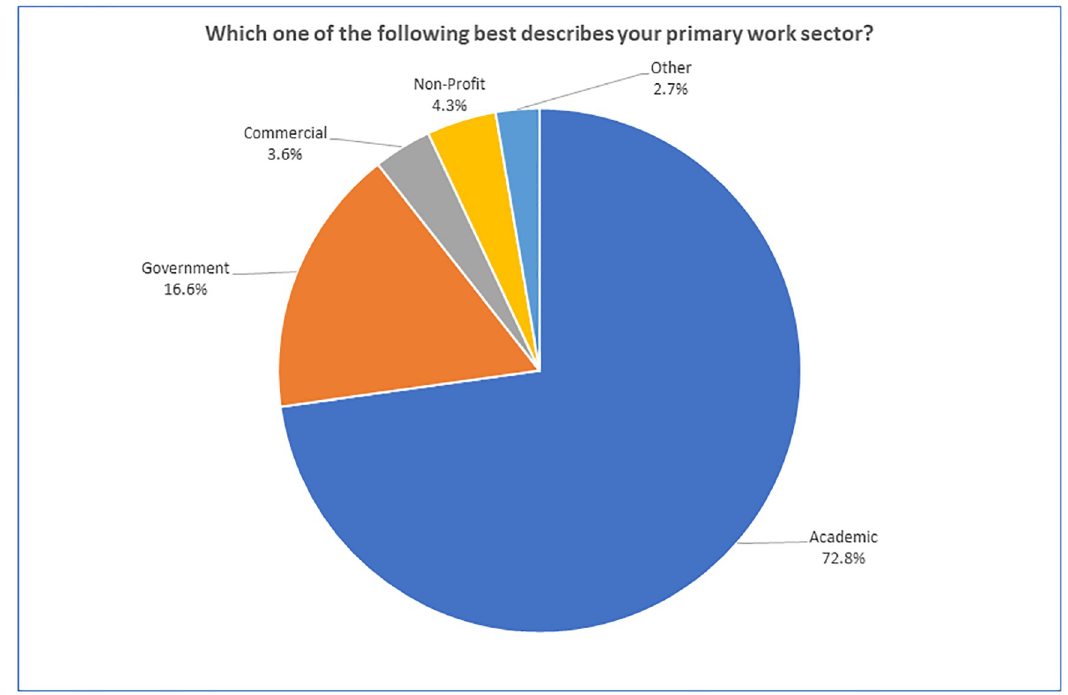
Fig 2. “Which one of the following best describes your primary work sector?” (n =